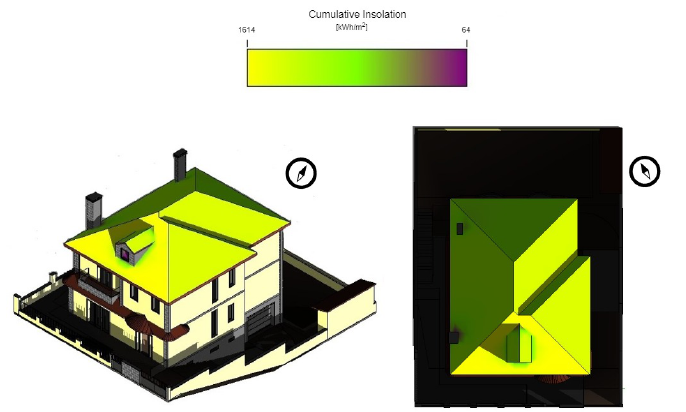
Figure 1. Simulation results: 2021’s annual cumulative insolation.